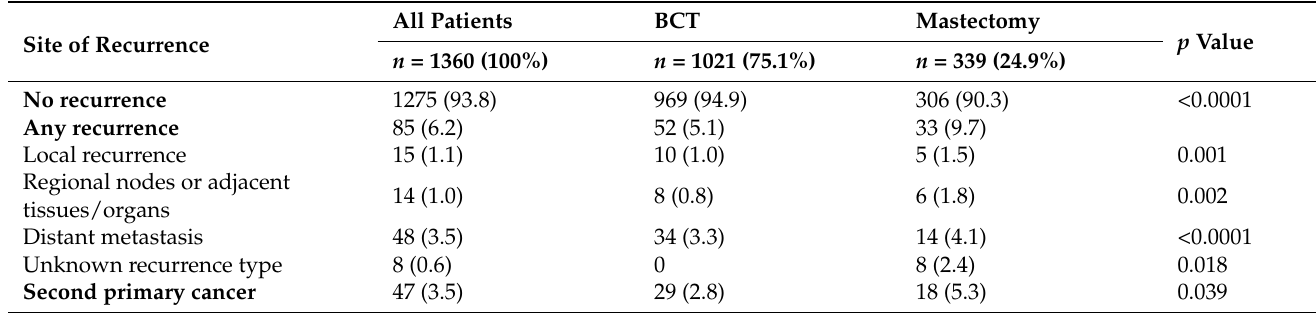
Table 3. Cumulative incidence of local, regional, and distant recurrence for patients treated with breast-conserving therapy or with mastectomy.